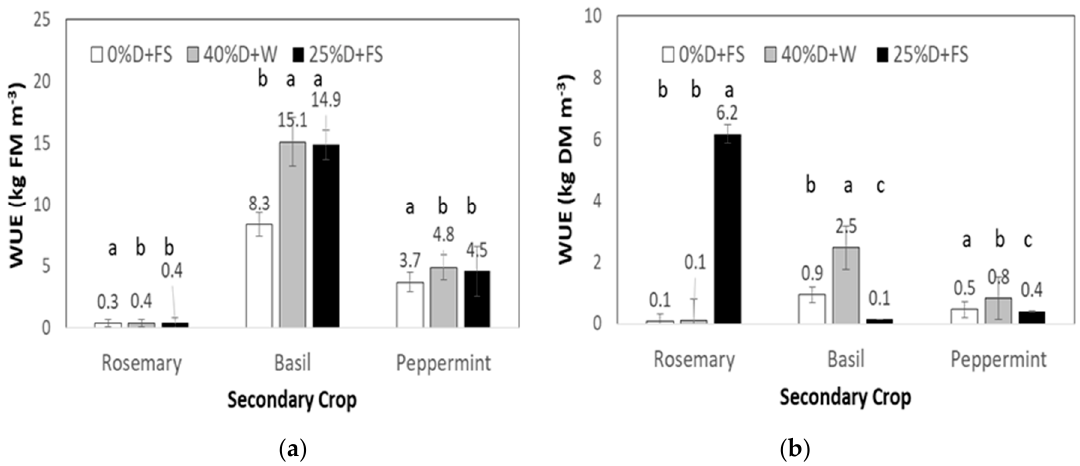
Figure 4. Water use efficiency (WUE, kg m − 3 ) based on ( a ) Fresh matter (FM) and ( b ) Dry matter (DM) of the secondary crops (Rosemary, Basil, Peppermint) studied during the 1st experimental period. Different letters above bars within a crop indicate statistically significant differences ( p < 0.05).